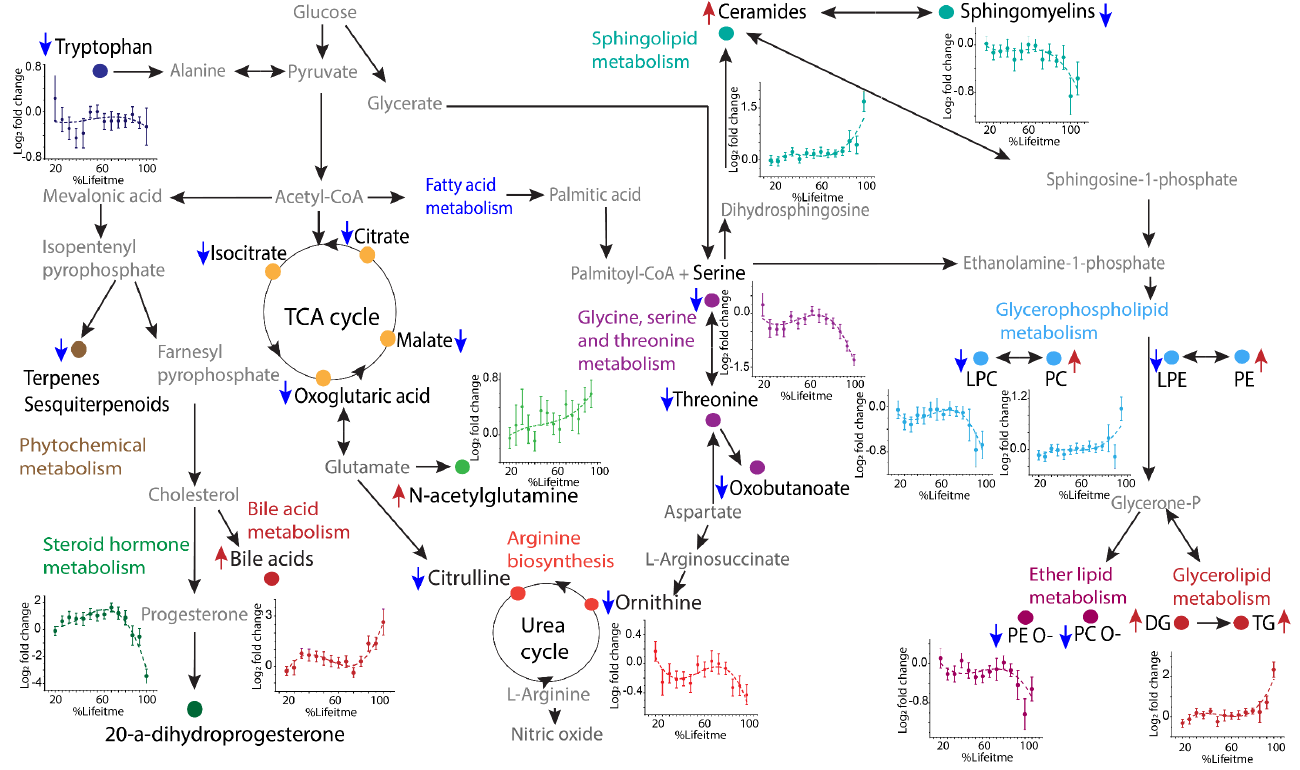
Figure 5. Pathway analysis showing key metabolic alterations observed in TKO mice. Metabolites and lipid classes associated with HGSC development are represented as solid symbols and colored based on their corresponding pathway. Intermediates connecting the pathways are shown in grey text. Blue arrows pointing downwards indicate the metabolite showed an overall decrease in TKO animals compared to TKO controls while the red arrows pointing upwards indicate the metabolite increased in TKO animals. Pathway information was derived from the Kyoto Encyclopedia of Genes and Genomes, MetaboAnalyst, Lipid Pathway Enrichment Analysis, and existing scientific litera-